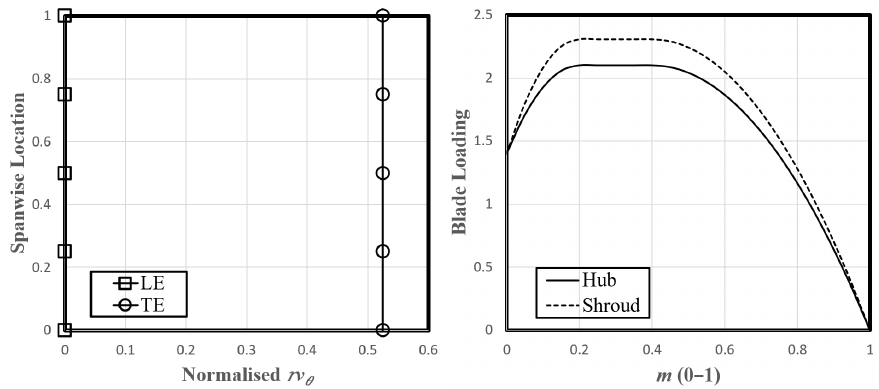
Figure 5. Baseline spanwise rv θ and streamwise blade loading.